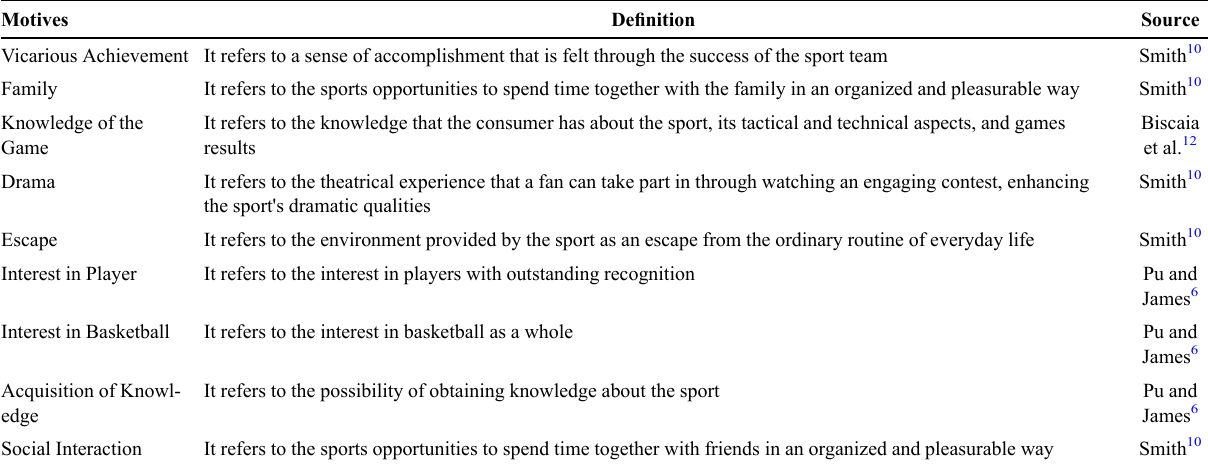
Table 1 - Definition of sport consumer motives in the